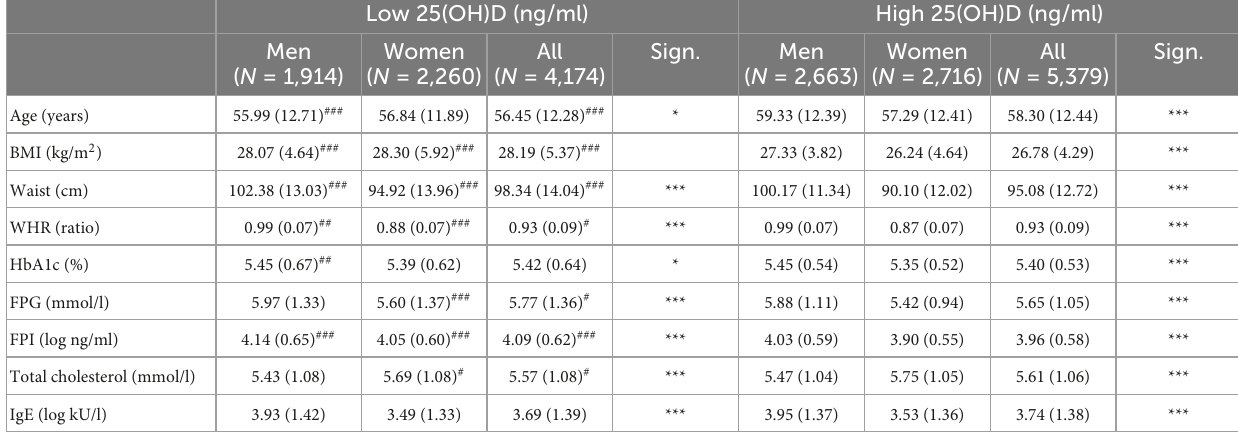
TABLE 2 Characterization of the LIFE-adult-study cohort according to low and high 25(OH)D (vitamin D)